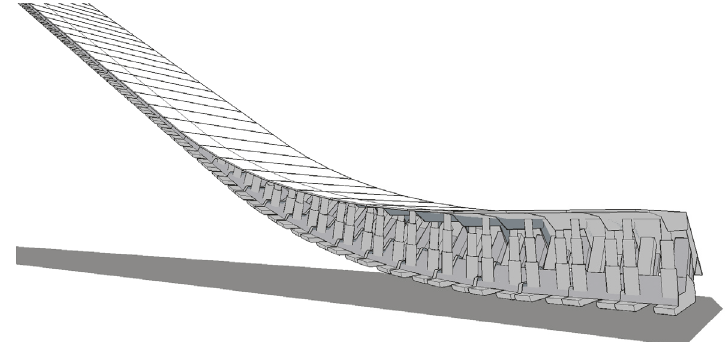
Figure 10: 3D views of shield layout for one LMSG panel.